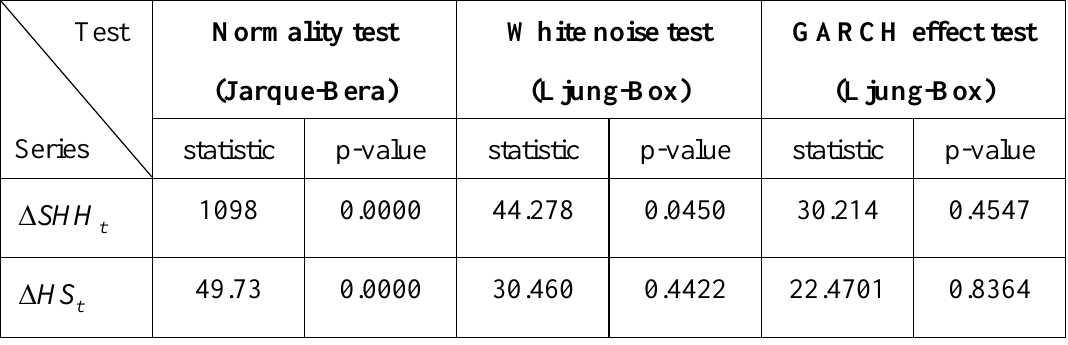
Table 9: Model diagnostic statistics for